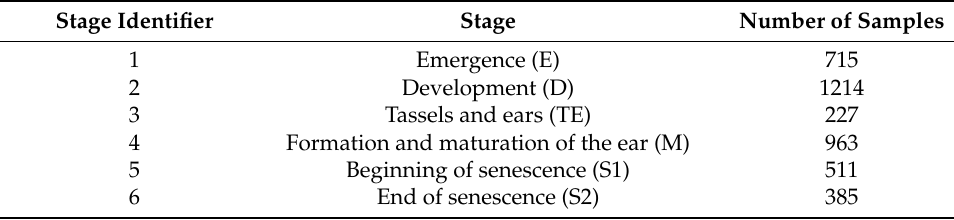
Table 2. Number of samples per class for the six phenological